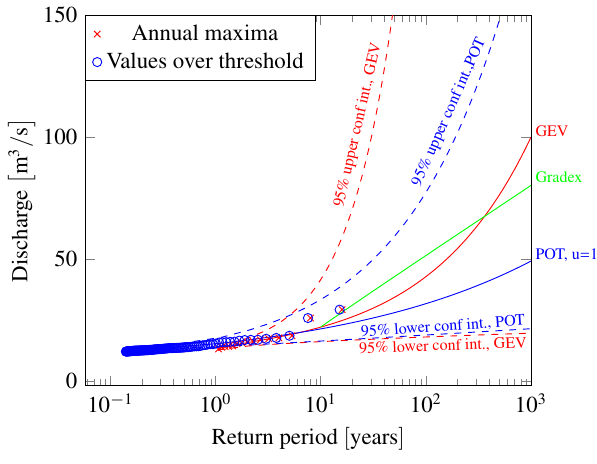
Figure 3. Extrapolation of the discharge data with the annual max- ima method using the GEV distribution, the POT method and the Gradex method.